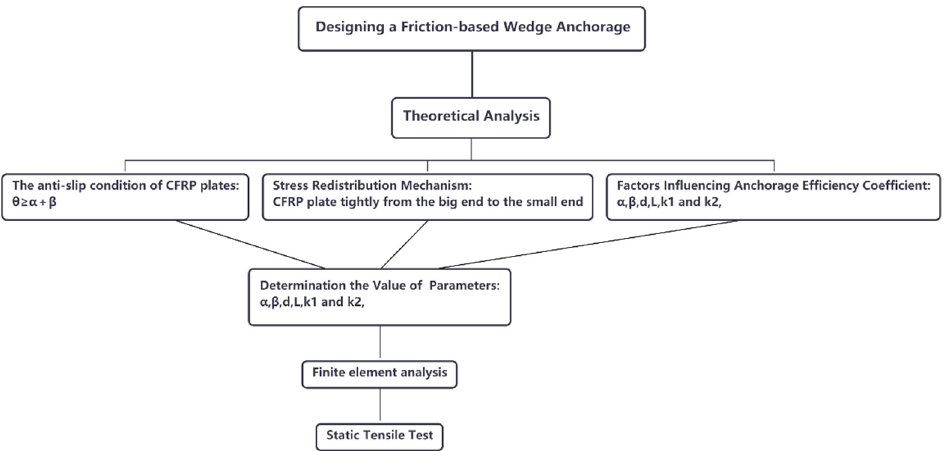
Figure 14. The flow chart of the analysis process.